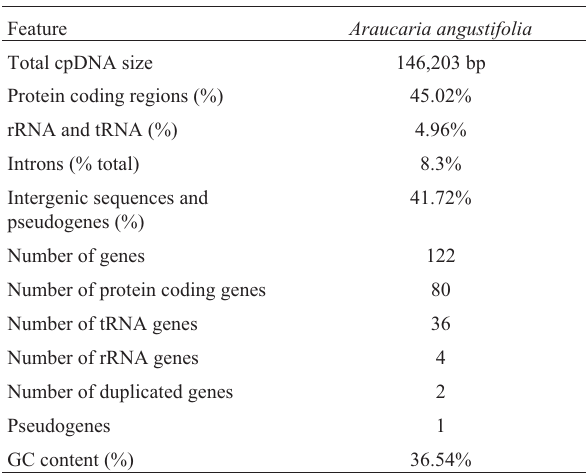
Table 1 - Summary of the Araucaria angustifolia chloroplast genome fea- tures. Feature